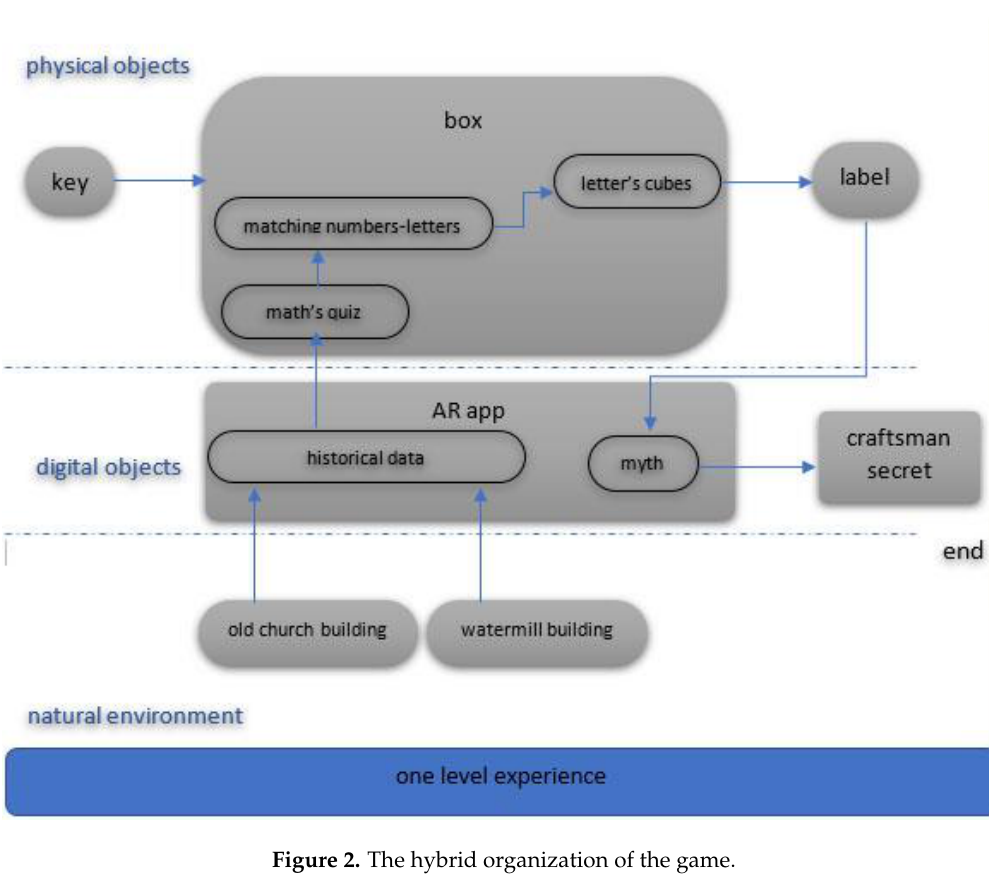
Figure 2. The hybrid organization of the game.